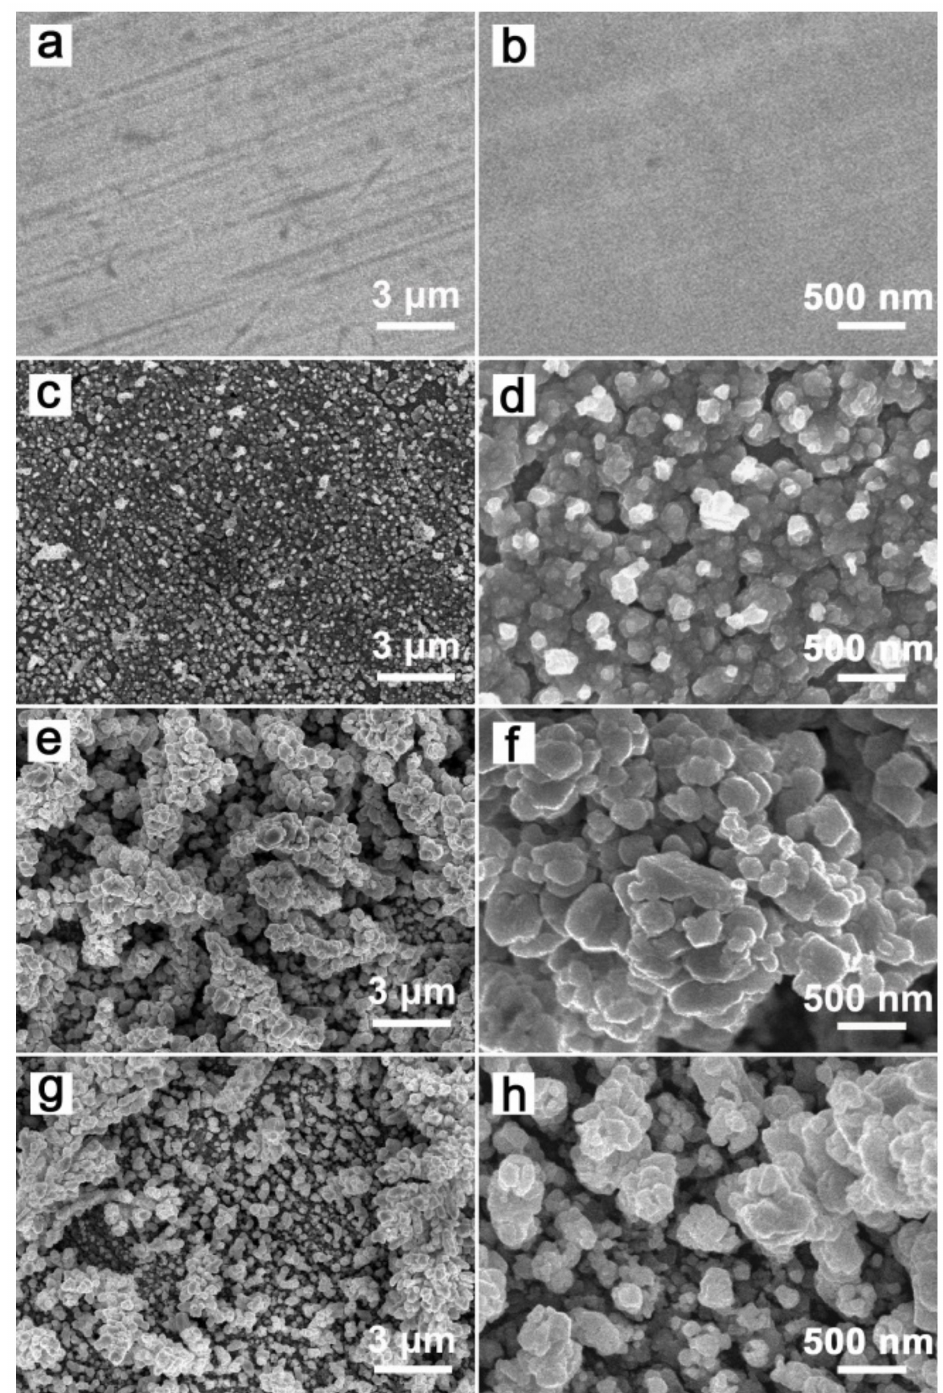
Figure 1. SEM images of the samples: ( a , b ) copper sheet; ( c , d ) GCF-0; ( e , f ) GCF-0.2; ( g , h ) GCF-0.4. Figure 2a shows the XRD patterns of the above four samples. As can be seen from the figure, the diffraction peaks of the GCF samples were located at the same 2 θ values as those of the pure copper sheet (JCPDS No.4-836), and there was no impurity peak. The grain size of each sample was approximately 30 nm. XPS analysis (Figure 2b) shows